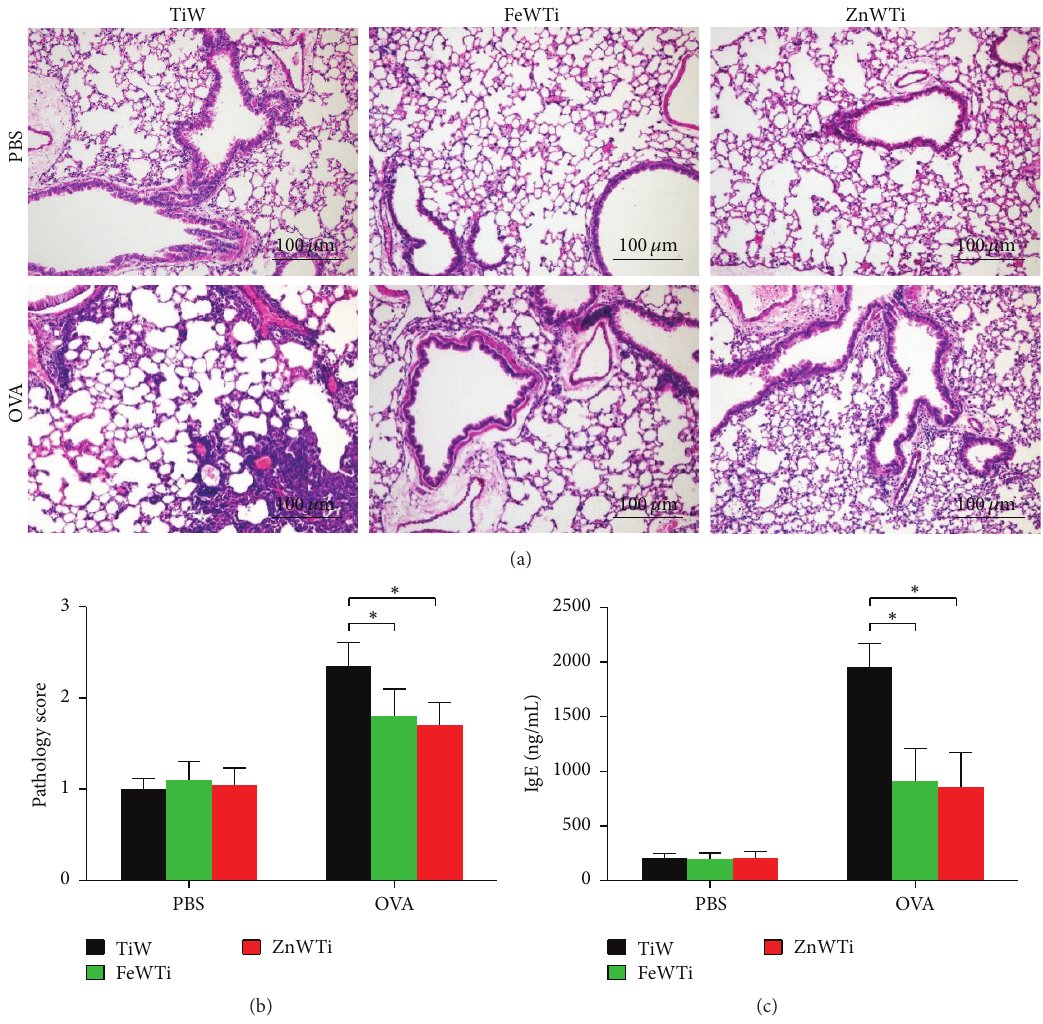
Figure 1: Polyoxometalates FeWTi and ZnWTi reduce OVA-induced lung inflammation. (a) Lung H&E staining; (b) lung pathology score; (c) serum IgE level measured by ELISA; bars = SEM; 𝑛 = 7 mice/group/experiment; scale bar = 100 𝜇 m; ∗ 𝑝 < 0.05 compared to mouse treated with TiW. Data are representative of 3